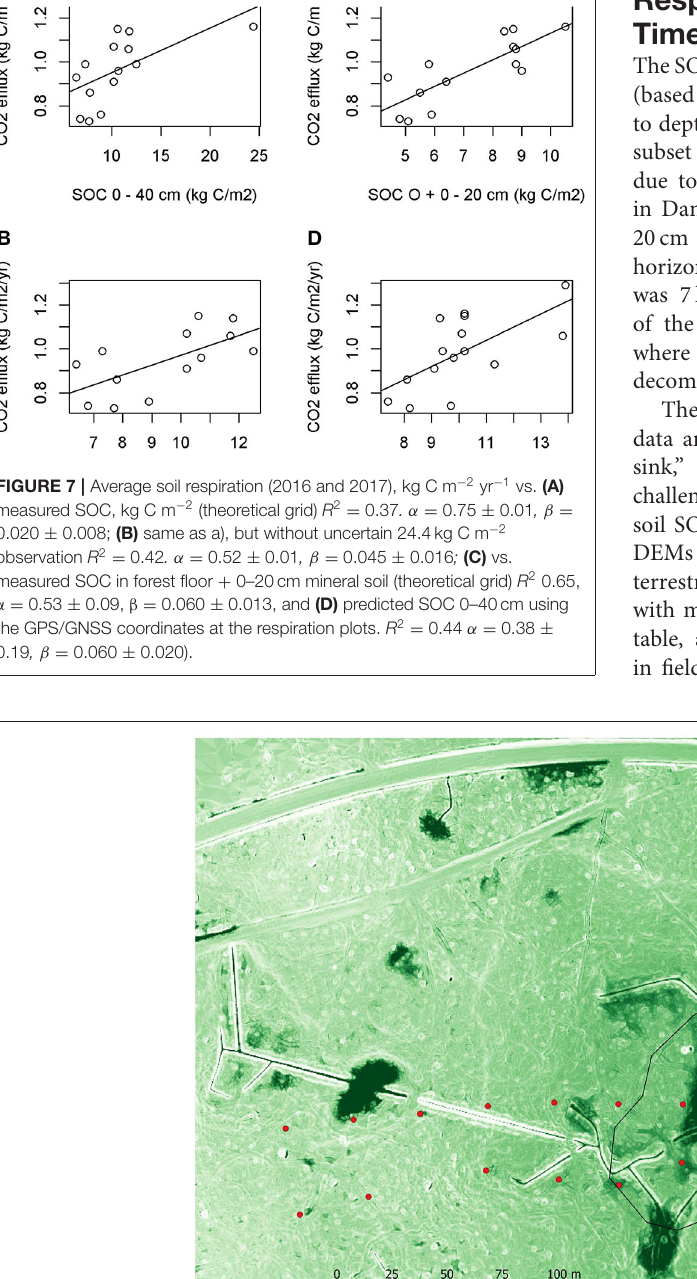
Frontiers in Forests and Global Change |